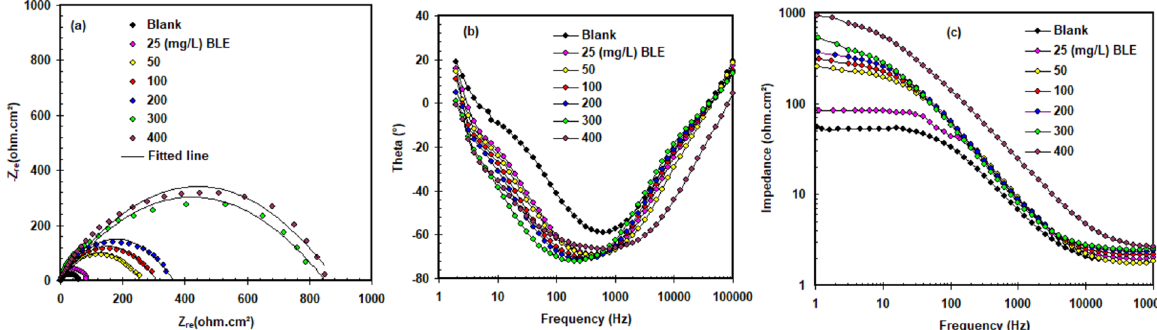
Figure 6. Impedance spectra includes ( a ) Nyquist, ( b ) Bode-phase angle and ( c ) Bode-module plots for X52- steel corrosion in pickling solution (1.0 M HCl) with and without varying concentrations of BLE extract at 298 K.